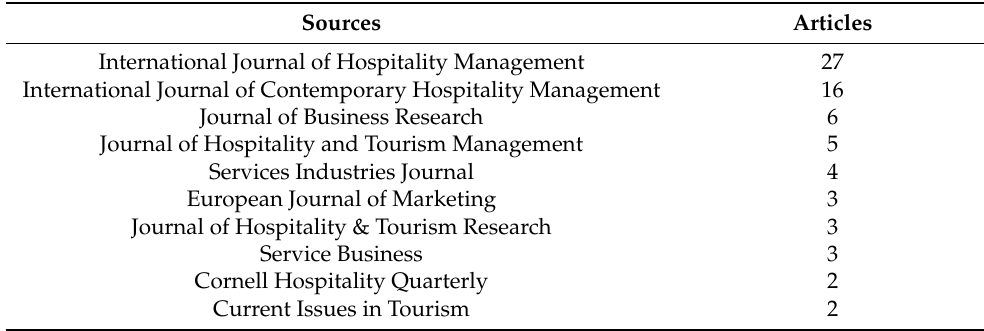
Table 1. Most relevant sources.